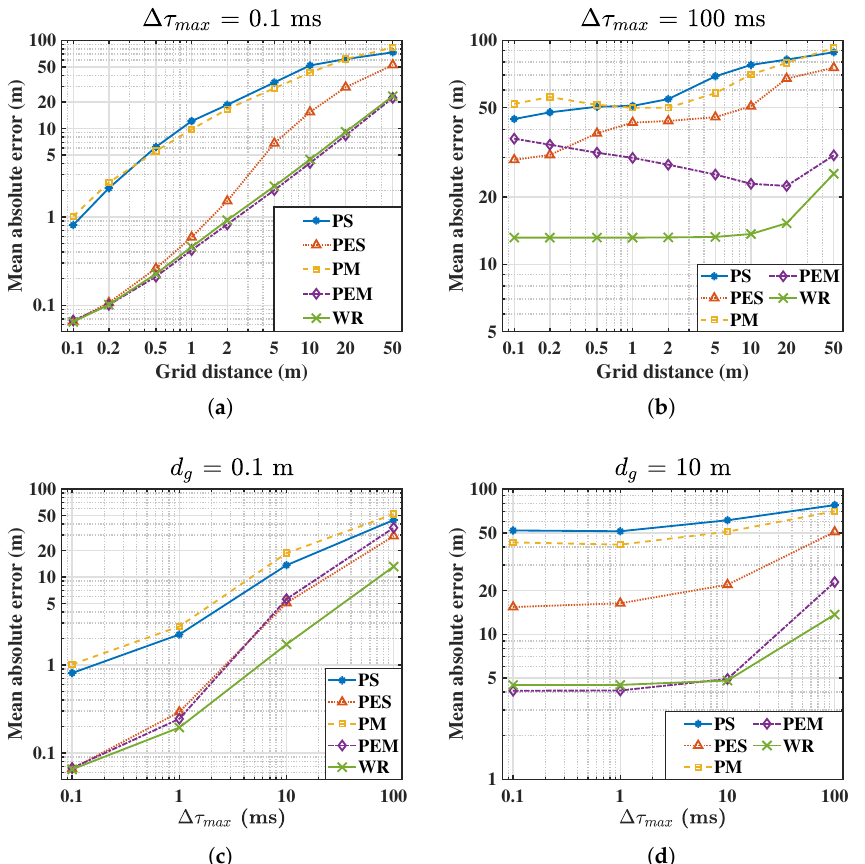
Figure 6. The mean absolute errors (MAEs) under different conditions. ( a ) small steering TDOA uncertainty (ST) ( ∆ τ max = 0.1 ms, d g ∈ [ 0.1 m,50 m ] ); ( b ) large steering TDOA uncertainty level